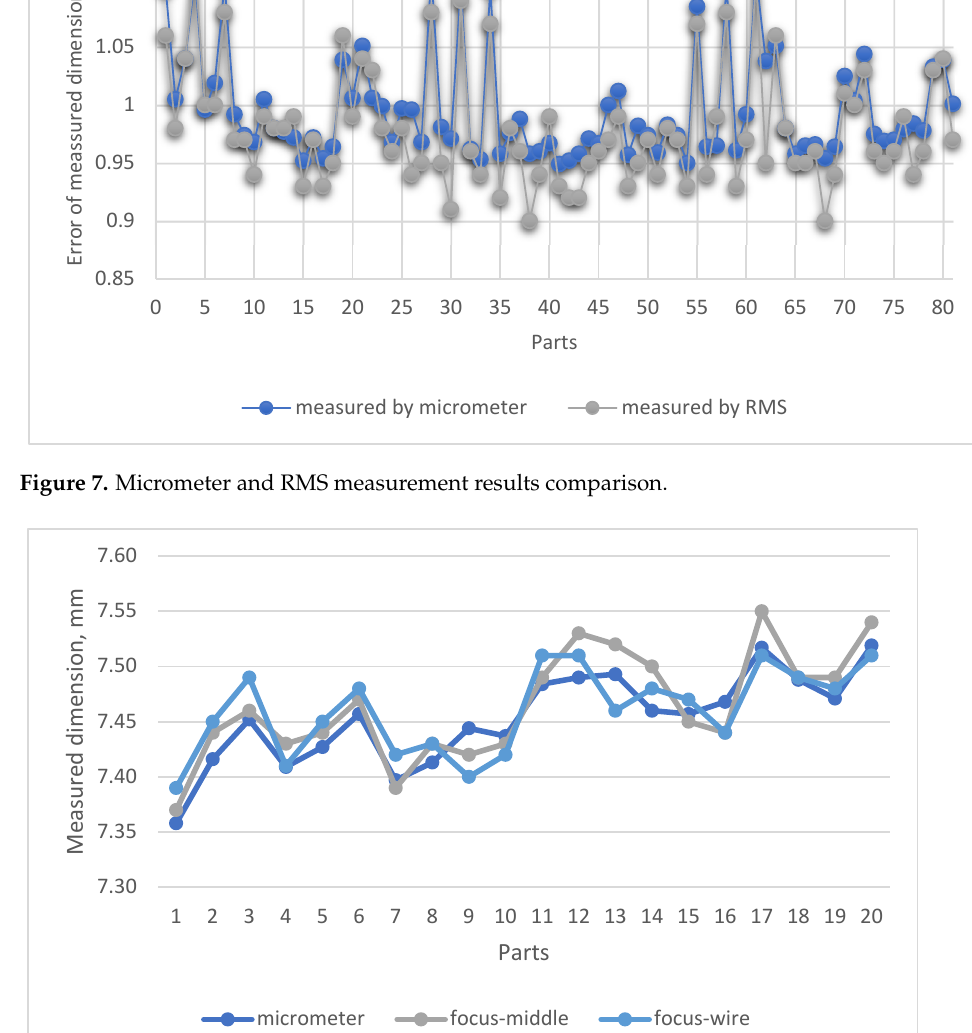
Figure 7. Micrometer and RMS measurement results comparison.